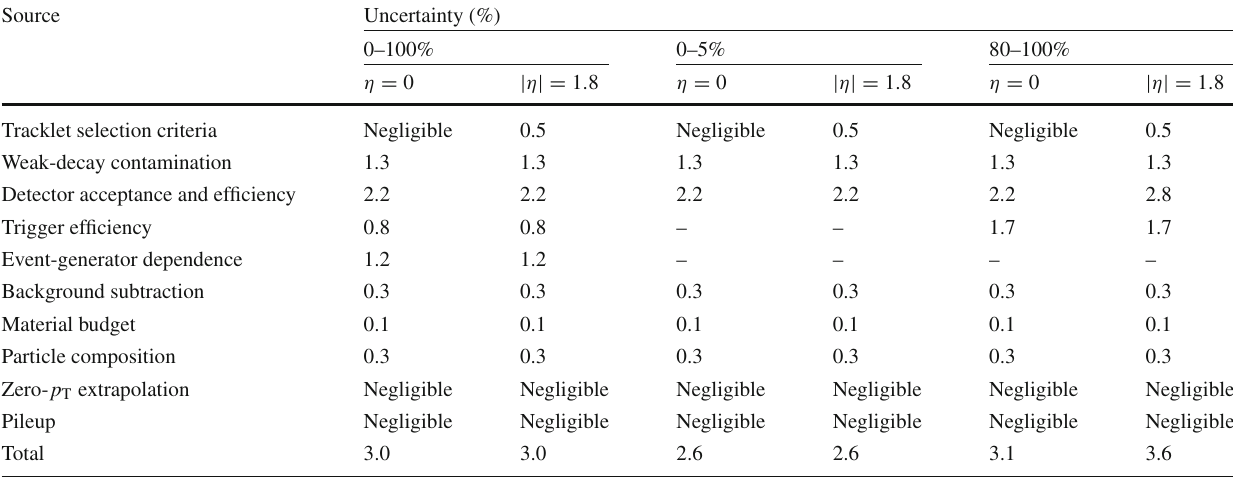
Table 3 Overview of the sources of systematic uncertainties